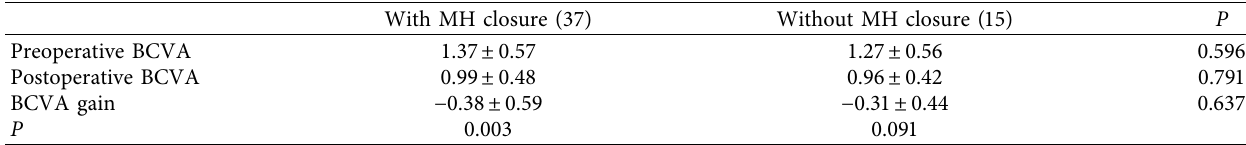
Table 3: Comparison of BCVA in eyes with or without MH